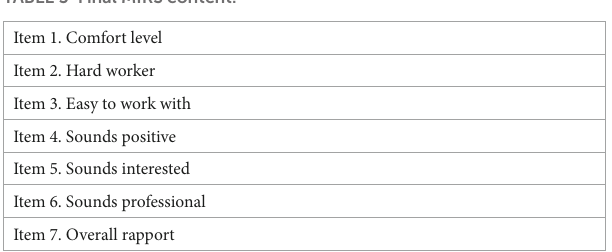
TABLE 3 Final MIRS